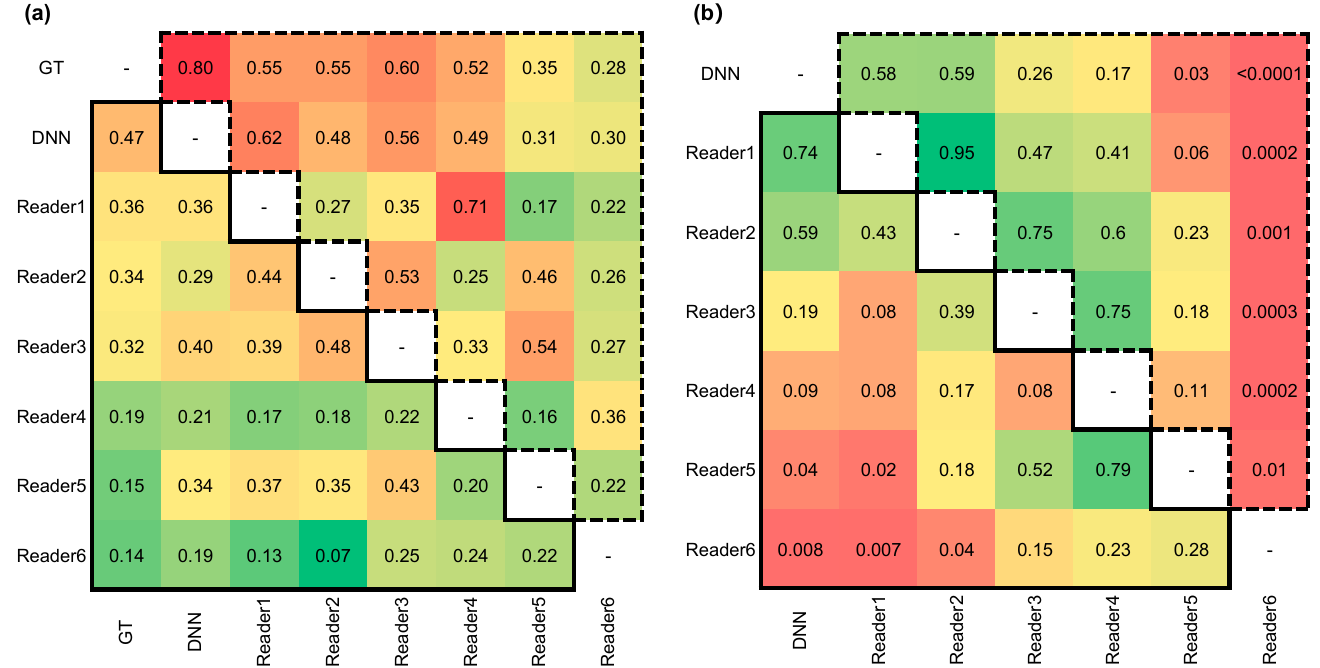
Figure 5. The Cohen’s kappa values and p -values for DNN model and six readers. The statistical values contained in a